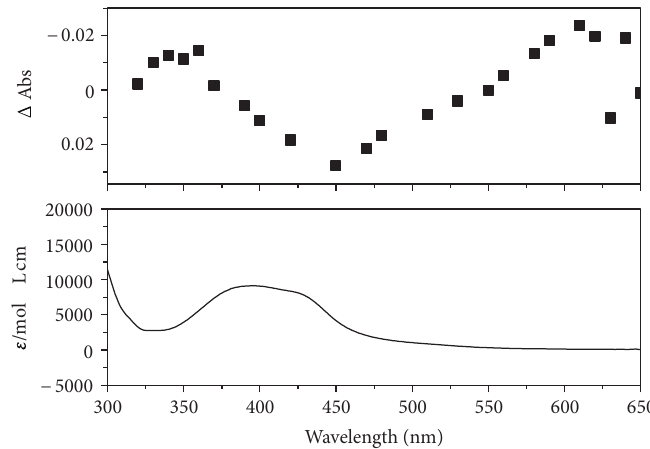
F 6: Transient (upper) and experimental (low) absorption spectra of complex I in acetonitrile.